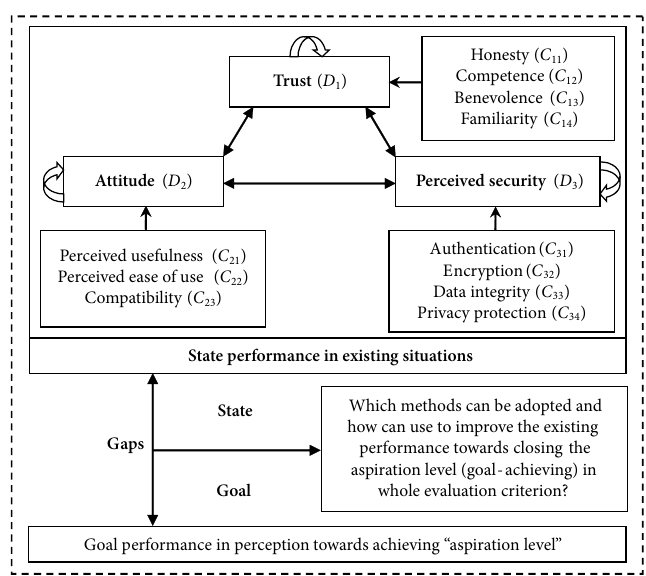
Figure 1. Research framework of m-commerce improvement